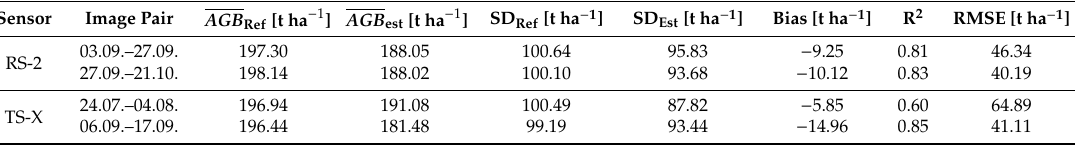
Table 6. Validation statistics of AGB per image